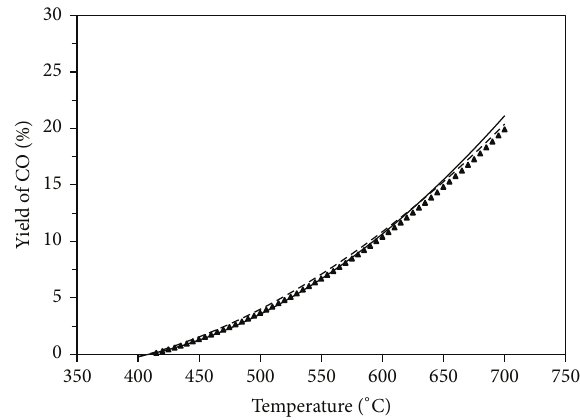
Figure 12: Average yield of CO for the reverse water gas shift reac- = 𝑃 = 1 kPa, balance He, GHSV = 282000 h −1 , tion at 1atm, 𝑃 H 2 CO 2 and 50 mg of Cu 𝑥 Ni 1−𝑥 / 𝛾 -Al 2 O 3 catalyst: The solid line represents Cu 20 Ni 80 / 𝛾 -Al 2 O 3 catalysts, the triangles represent Cu 50 Ni 50 / 𝛾 - Al 2 O 3 catalysts, and the dashed line represents Cu 80 Ni 20 / 𝛾 -Al 2 O 3